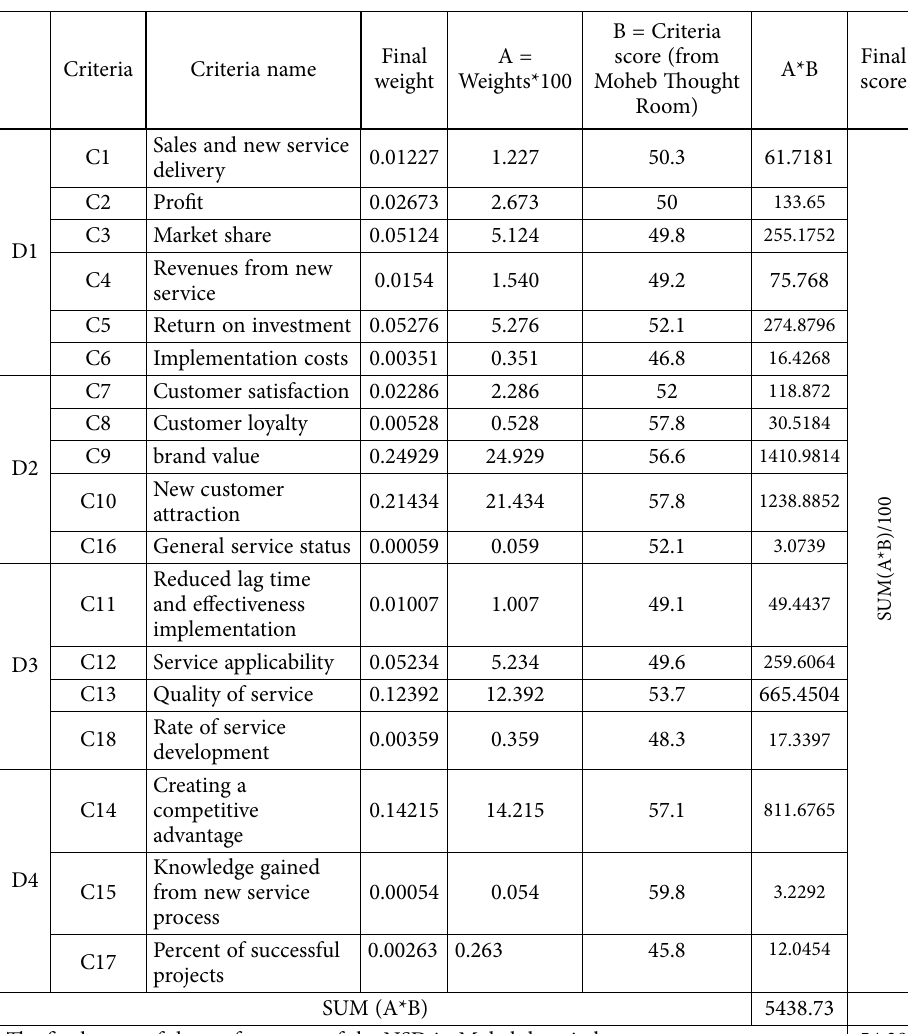
Table 9. Hospital status for each